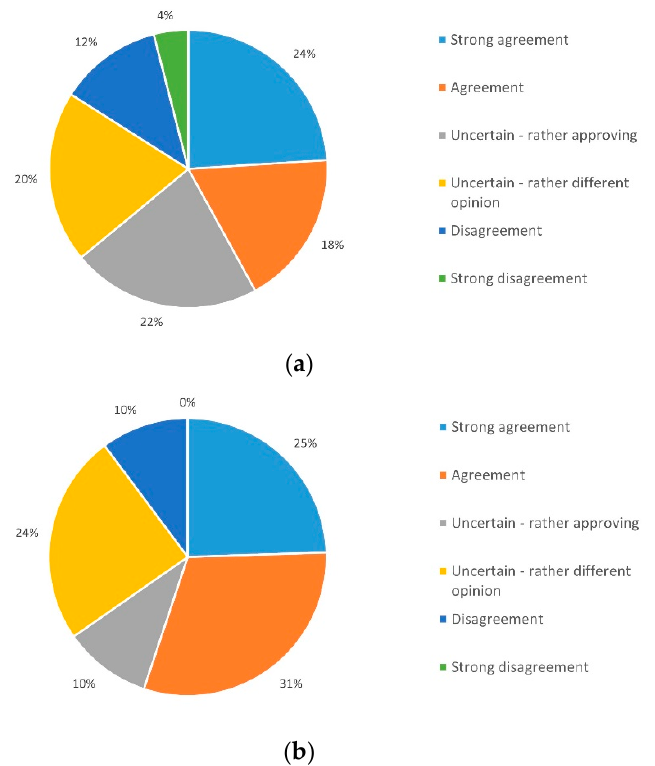
Figure 4. Expectation for improvements in terms of ( a ) individual health situation and ( b ) realization of ideas for improvements .